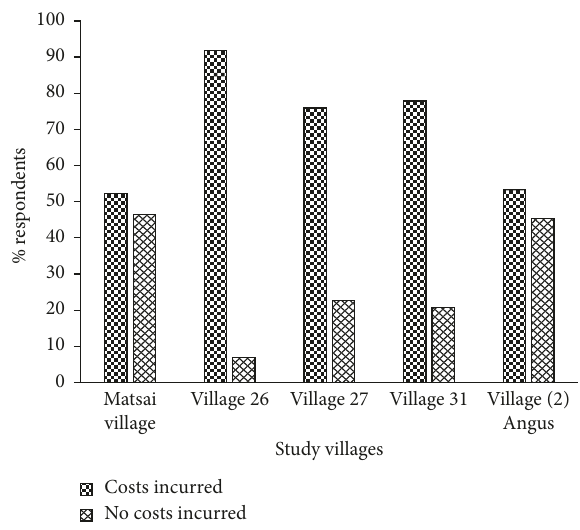
Figure 3: Claims of wildlife-induced costs by local communities across the villages.